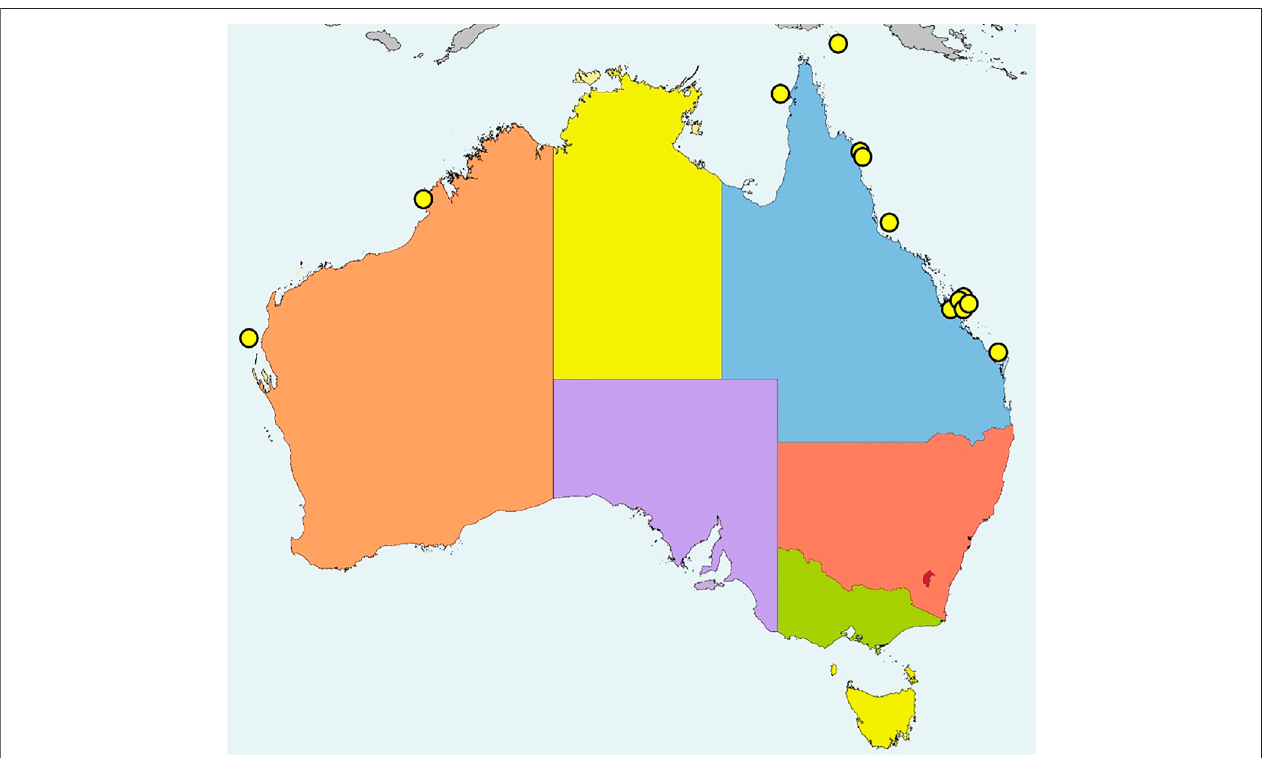
FIGURE 1 | Distribution of 13 sea snake bites in Australia from January 2002 to August